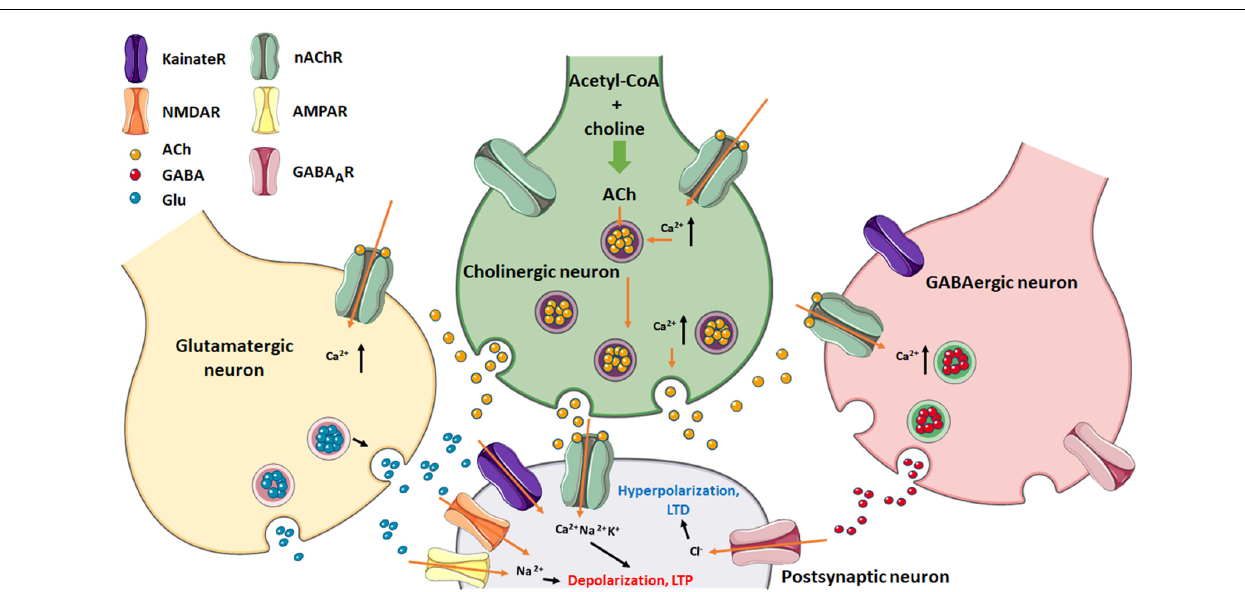
FIGURE 3 | Postsynaptic neuron regulation via excitatory (glutamatergic/cholinergic) and inhibitory (GABAergic) afferents. Note the presence of nAChRs in the three presynaptic nerve endings as well as in the postsynaptic neuron. Glu can stimulate either NMDA- or AMPA-type glutamatergic receptors, which together with nAChRs, cause depolarization which leads to LTP of the postsynaptic membrane. GABA channel activation results in hyperpolarization of this membrane and favors LTD. Figure created using Servier Medical Art Commons Attribution 3.0 Unported License (http://smart.servier.com). Servier Medical Art by Servier is licensed